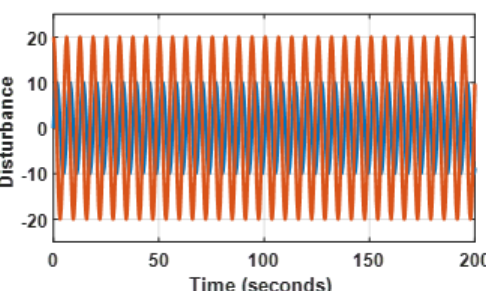
Figure 1. An external disturbance used in the experiments.